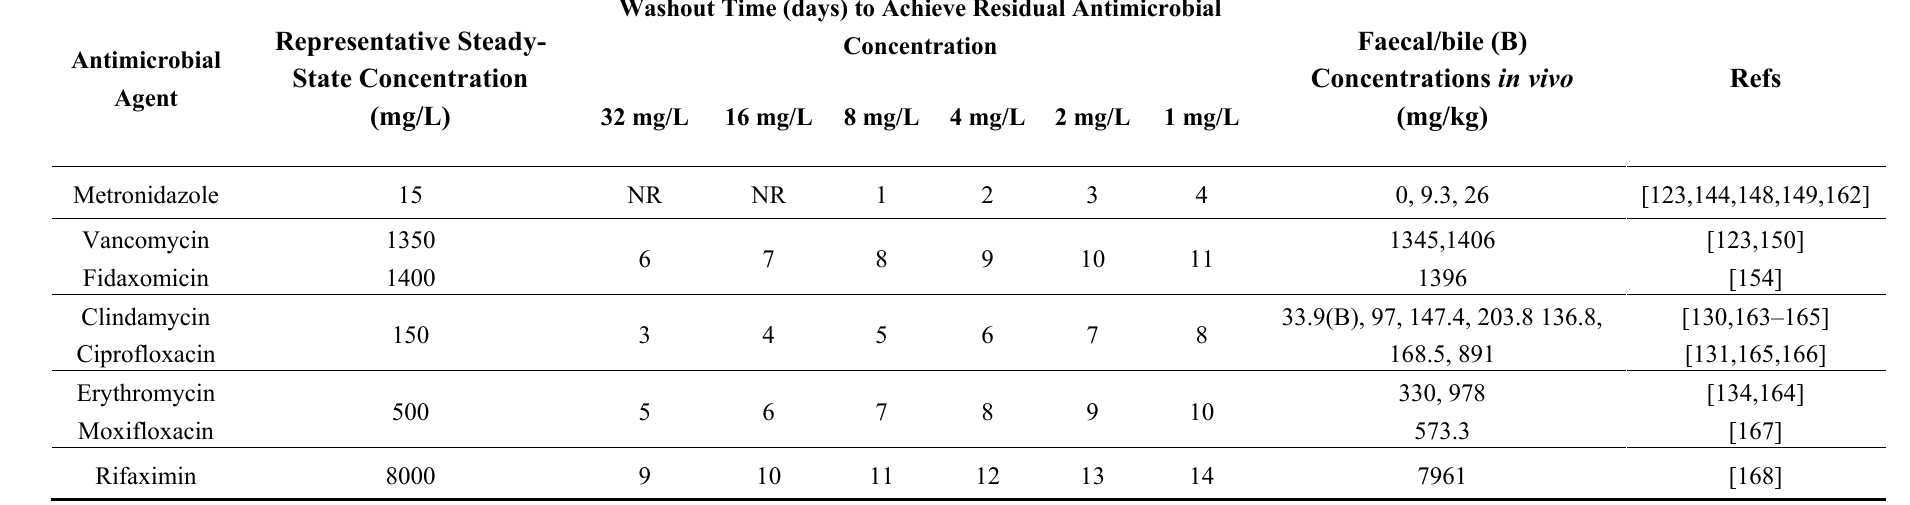
Table 4. Predicted washout of antimicrobial agents from the human colon using a mass-balance calculation assuming a gut transit time of 35 h (dilution rate = 0.029 h −1 ) and representative steady-state concentrations observed during antimicrobial dosing based on published data.